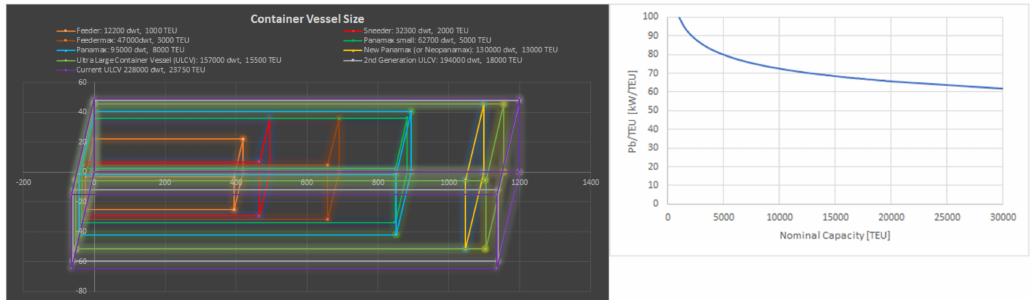
Figure 10. LEFT: Growth of container vessels size vs main dimensions, RIGHT: Growth in container-ship sizes and propulsion requirements per TEU, adapted from